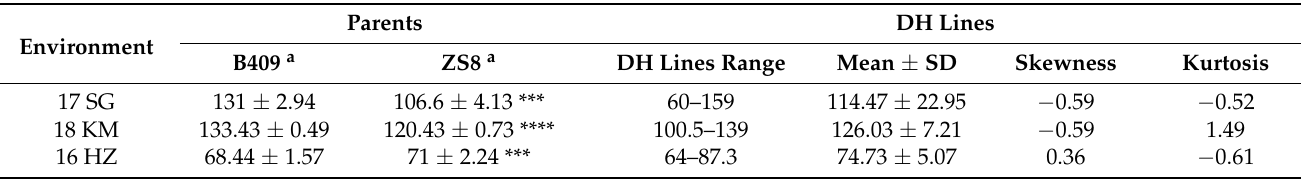
Table 1. Phenotypic variation of flowering time in the double haploid (DH) population and their parents. Environment